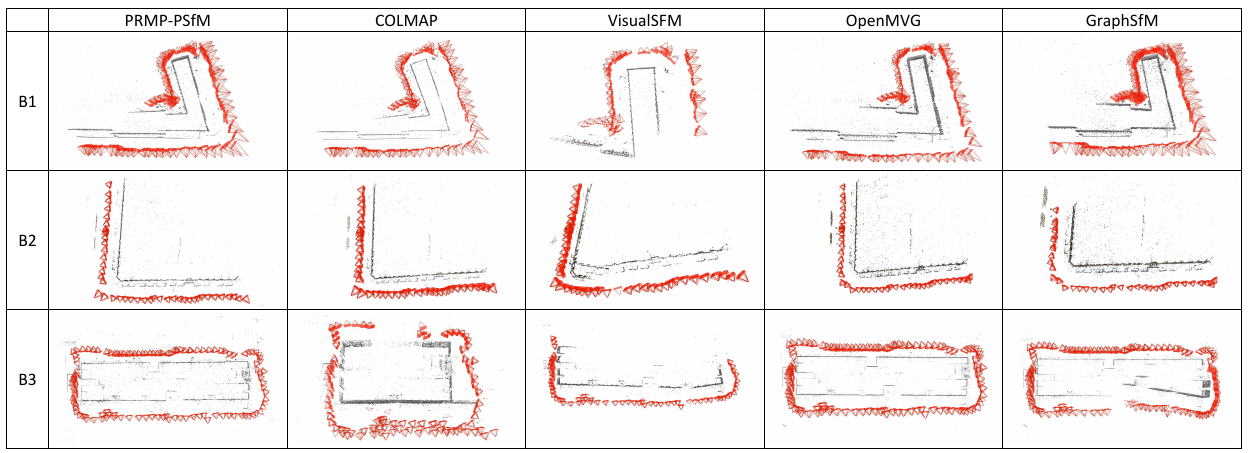
Figure 14. Sample images and correct reconstruction results of three benchmark datasets with both repetitive structures and very short baselines. From top to bottom: B1 , B2 and B3 .